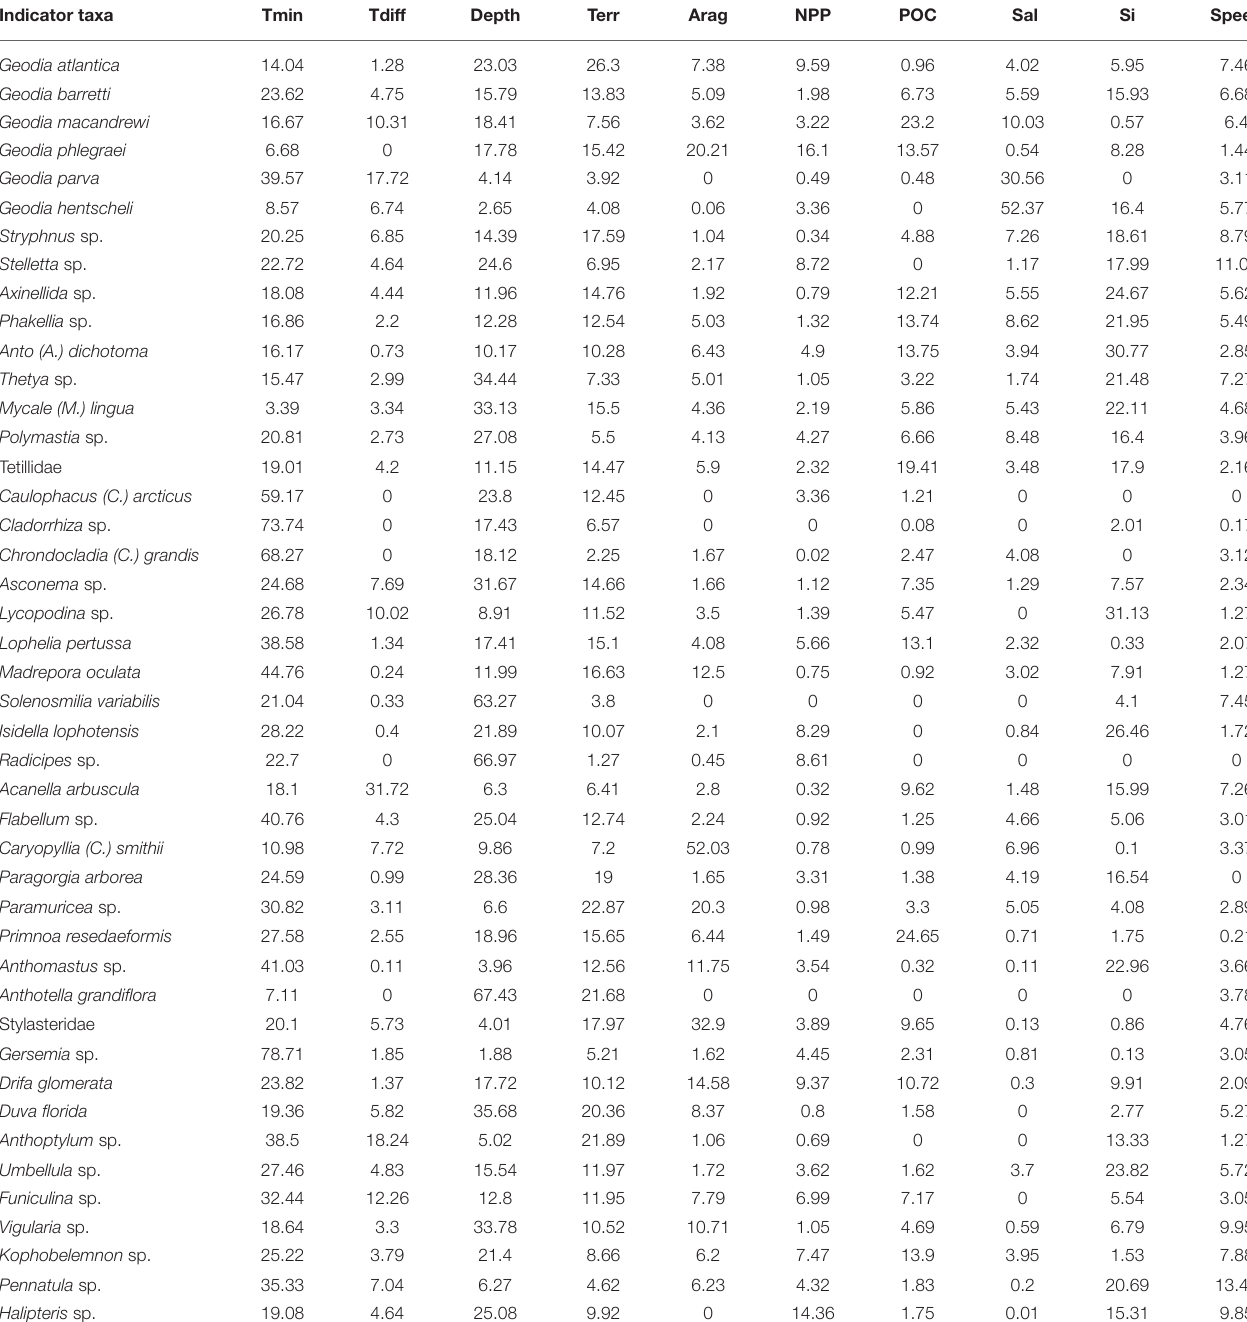
TABLE 4 | Permutation importance of environmental predictors: Minimum temperature (Tmin), temperature difference (Tdiff), bottom depth (depth), combined importance of terrain parameters (Terr), aragonite saturation state (Arag), mean net primary productivity (NPP), particulate organic carbon (POC), salinity (Sal), silica concentration (Si), and near-bottom current speed